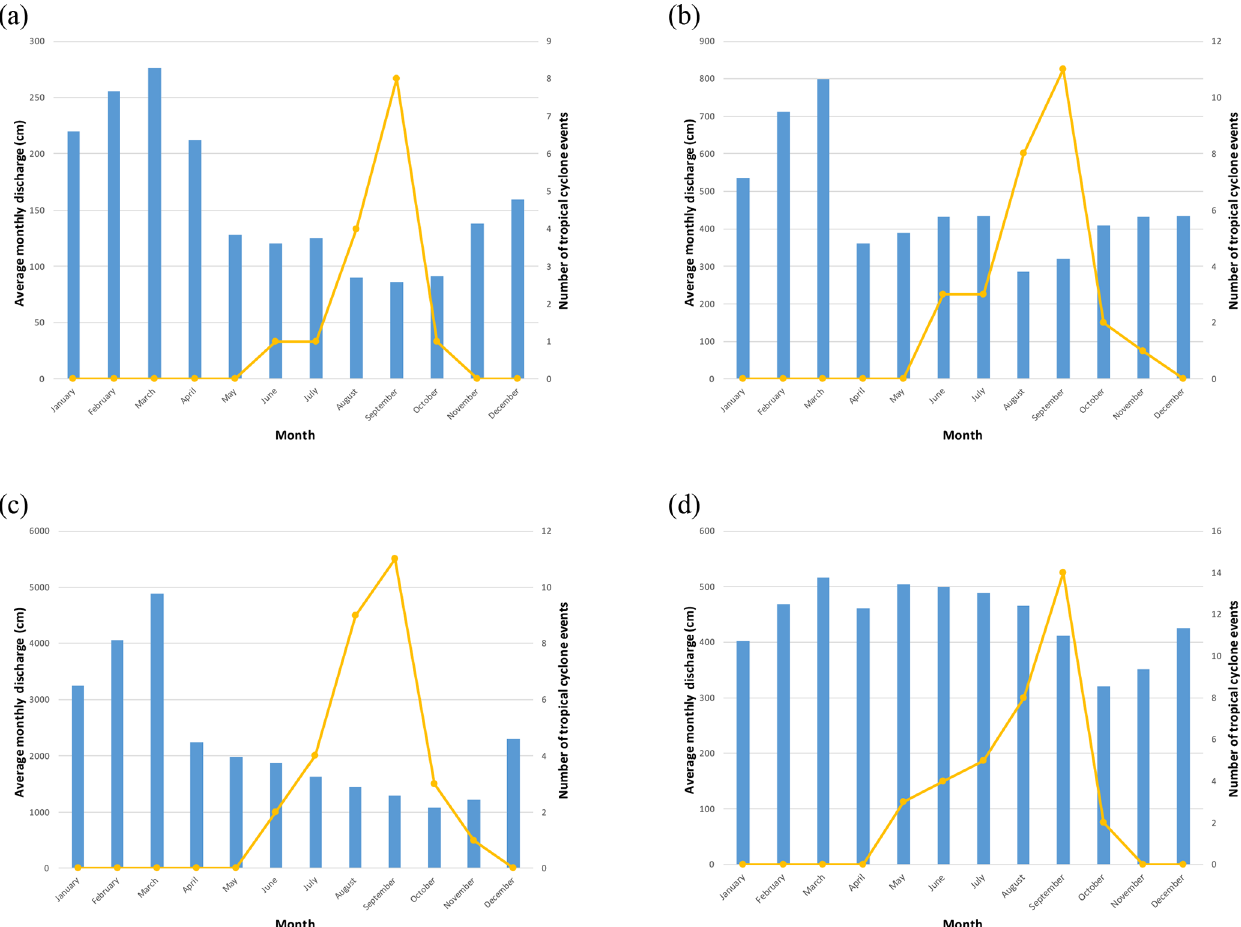
Figure 2. Comparison of average monthly discharge (blue bars) with the number of tropical cyclones occurring each month (yellow line) from 1998 to 2014 for the Neches (a) , Pearl (b) , Mobile (c) , and Roanoke (d) basins.